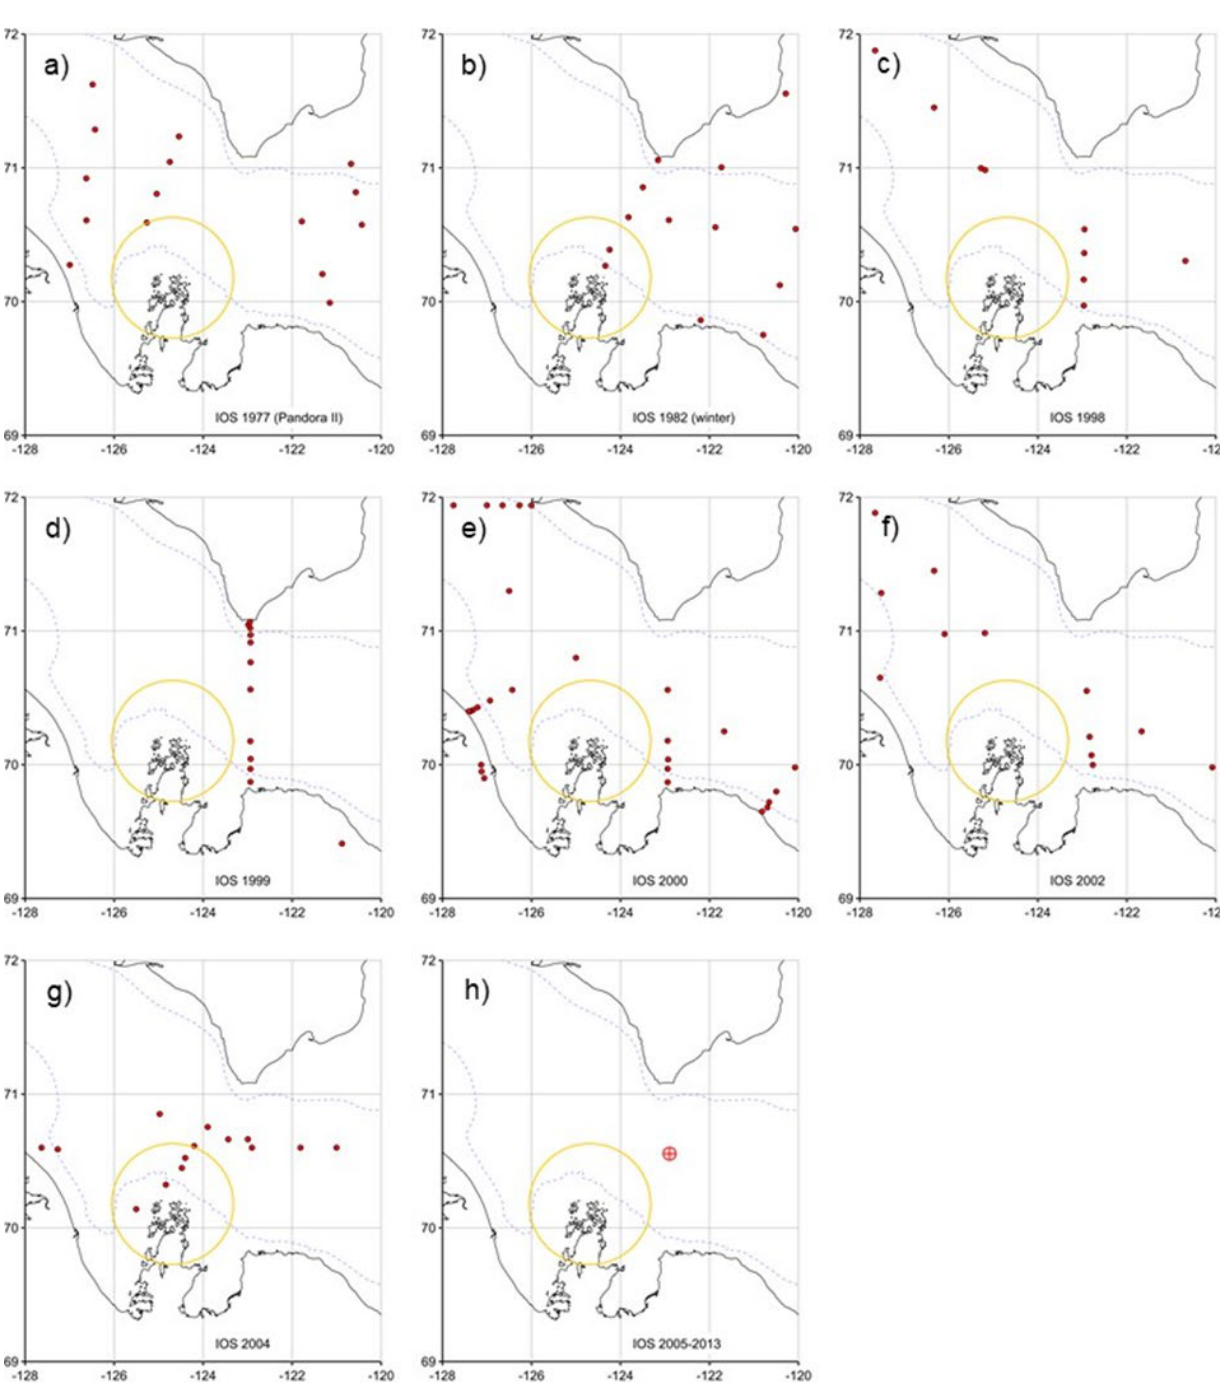
Figure 5. The locations of (a – g) of water profile surveys of temperature, salinity, chlorophyll a fluorescence, water transparency, dissolved nutrients, and dissolved oxygen conducted by the Institute of Ocean Sciences (Fisheries and Oceans Canada) within 100 km of the ANMPA between 1977 and 2004, and (h) the location of reference station A1 at the deepest point in the Amundsen Gulf where full-depth oceanographic profiles have been measured annually since 1997 (H. Melling, DFO, unpublished data). Maps provided by H.